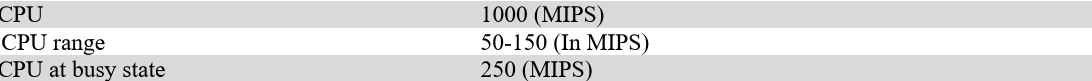
Specifications for VM and